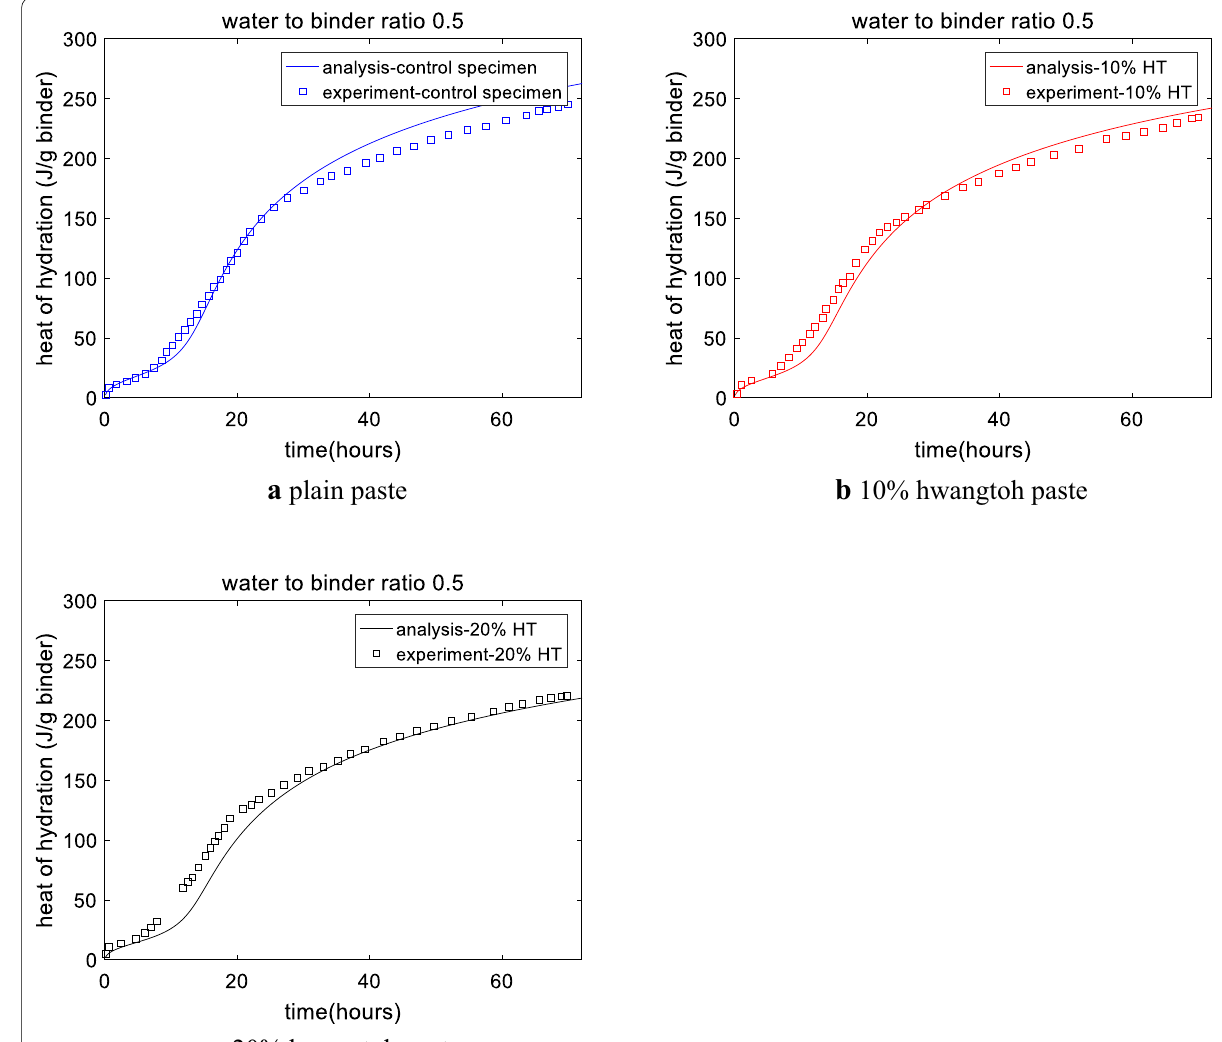
Fig. 6 Heat of hydration of cement–hwangtoh blends (water‑to‑binder ratio 0.5) (Lin et al. 2019).